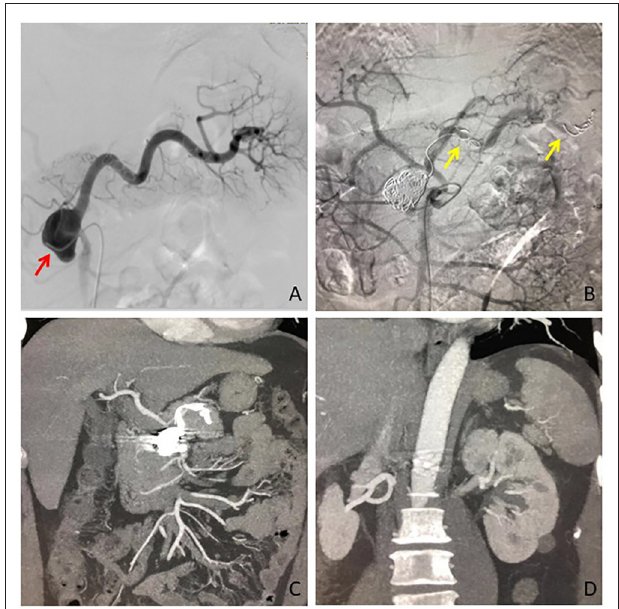
FIGURE 1 | The SAA was diagnosed in a patient with the symptom of abdominal discomfort. (A) Digital subtraction angiography confirmed the location of SAA at the initiation of the splenic artery, which arose from the superior mesenteric artery (red arrow). (B) The distal side of the SAA parent artery, aneurysm sac, and the proximal side was embolized by coils (yellow arrow) in sequence. (C) CT angiography at 3 months showed completely aneurysmal thrombosis, and (D) No splenic infarction occurred. SAA, splenic artery aneurysm.